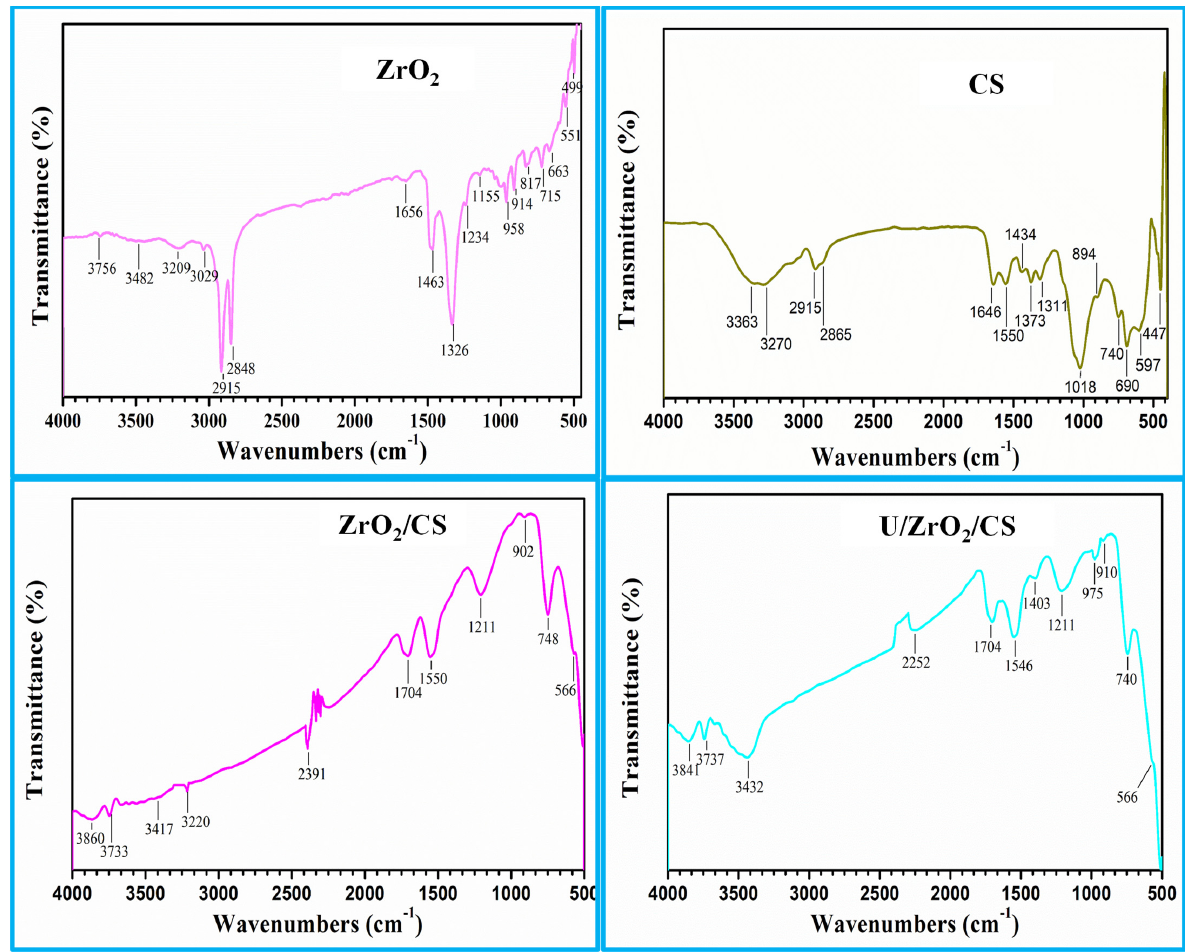
Figure 4. ZrO 2 , CS, ZrO 2 /CS, and U/ZrO 2 /CS FTIR